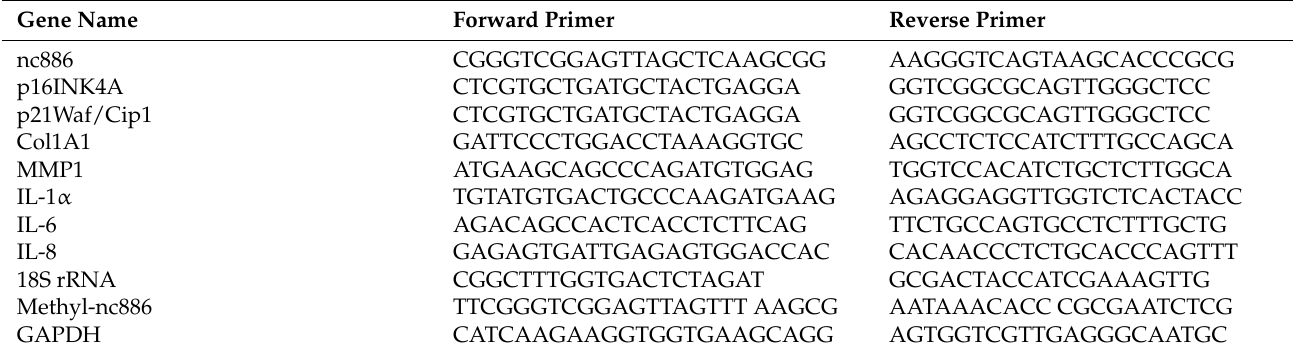
Table 1. Sequences of primers used Real-Time PCR and Methylation-Specific PCR.